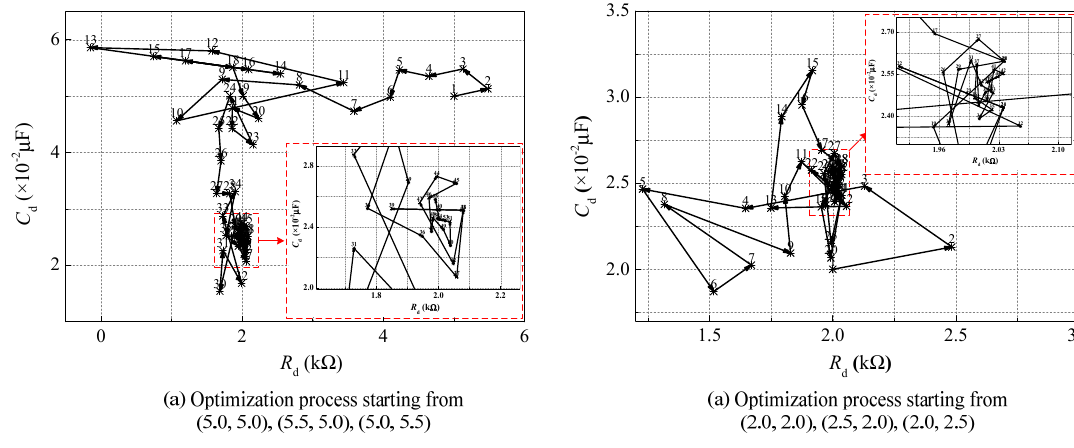
Figure 10. Optimization Processes from Different Initial Simplex.